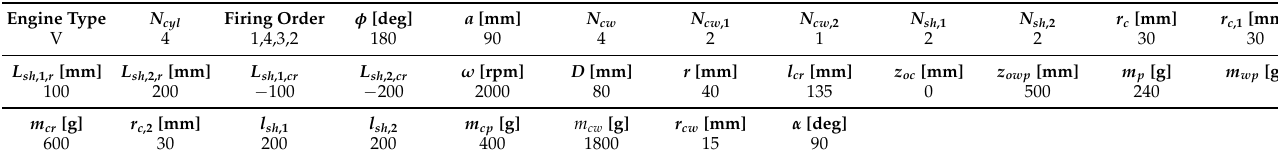
Table 4. Input data for the optimisation of a 4 cylinder V-engine.